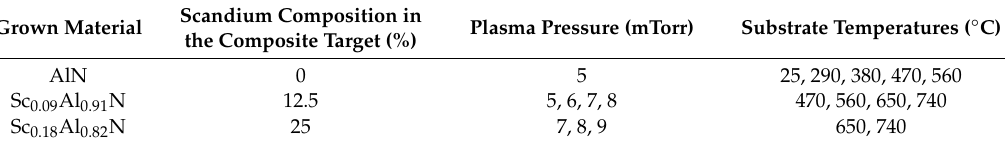
Table 3. Investigated sputtering parameters for each grown